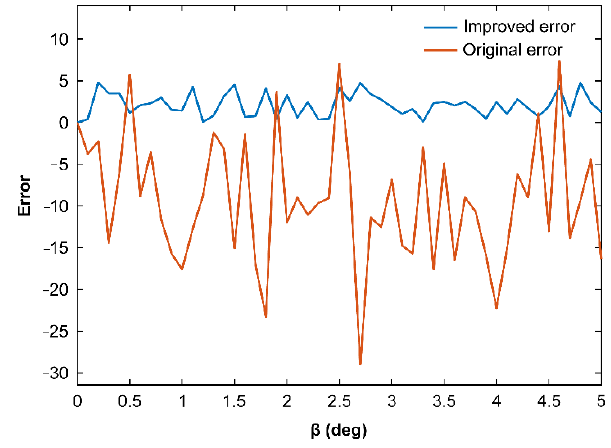
Figure 13. Precision error curve of the roll axis boresight pointing.